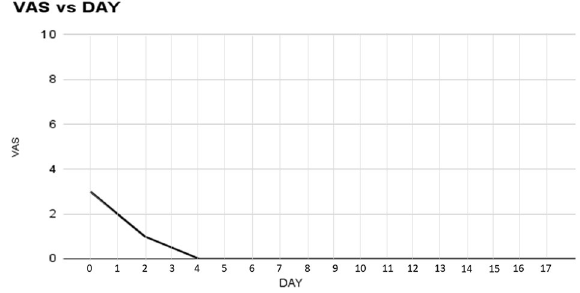
Figure 8. Postoperative mean VAS score assessment after laparoscopic hernia defect obliteration with ProFlor. Within 4th postoperative day all patients were